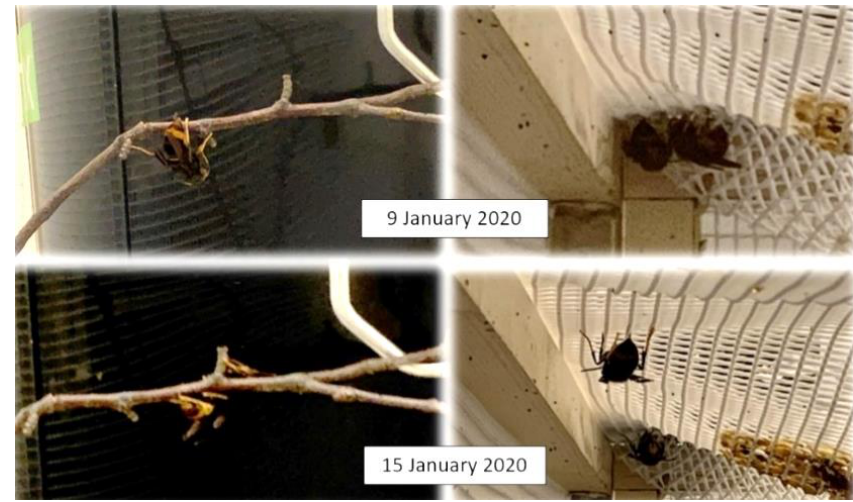
Figure 10. Vespa velutina hornets from nest 1 in state of lethargy in captivity.